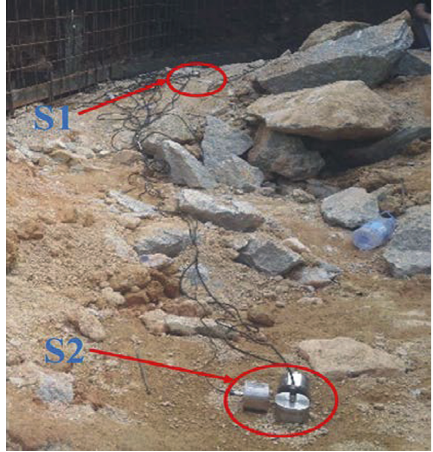
Figure 2: Photo of measuring points in vertical